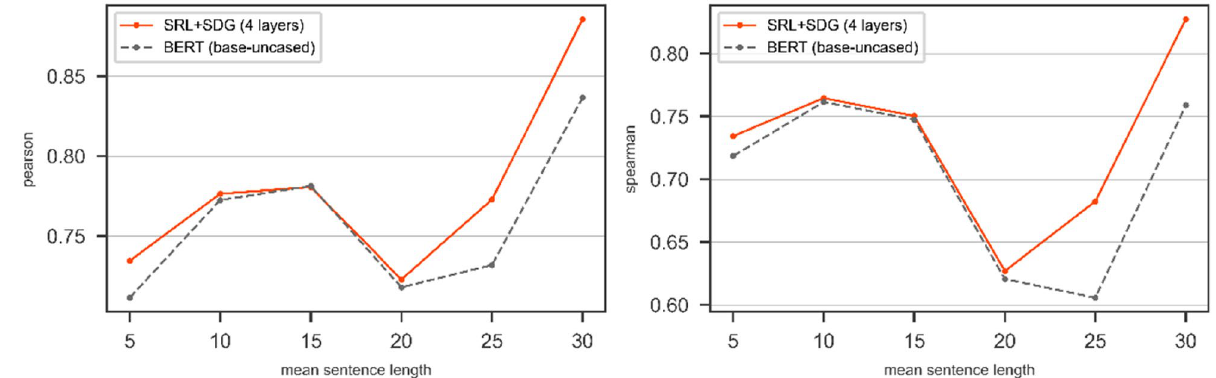
Figure 13. The results of BERT with bert‑base‑uncased config and the DGNN on top of the BERT on STS2017/ Test in terms of Pearson (left) and Spearman (right). The pair of sentences with mean length is categorized in the window [ − 2, 2]